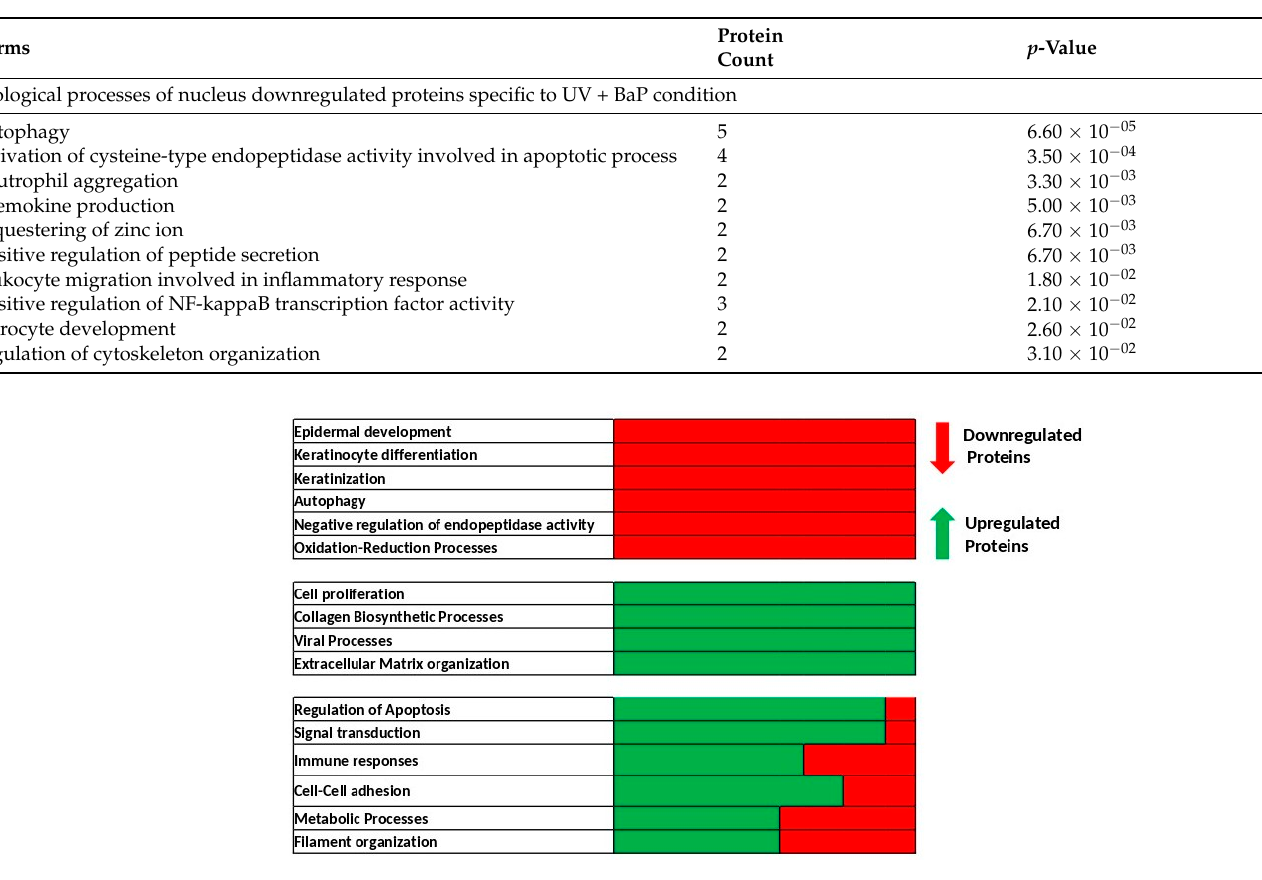
Figure 2. The major upregulated and downregulated biological processes following UV + BaP co- exposure. The heat map displays the major dysregulated biological process and the distribution of the identified proteins either upregulated (green color) or downregulated (red color), among each particular process. Some deregulated pathways solely harbor proteins that were all either downregulated (such as autophagy) or upregulated (such as cell proliferation) in the proteomics data, while other pathways have some of the proteins involved in these processes upregulated and others are downregulated (such as cell–cell